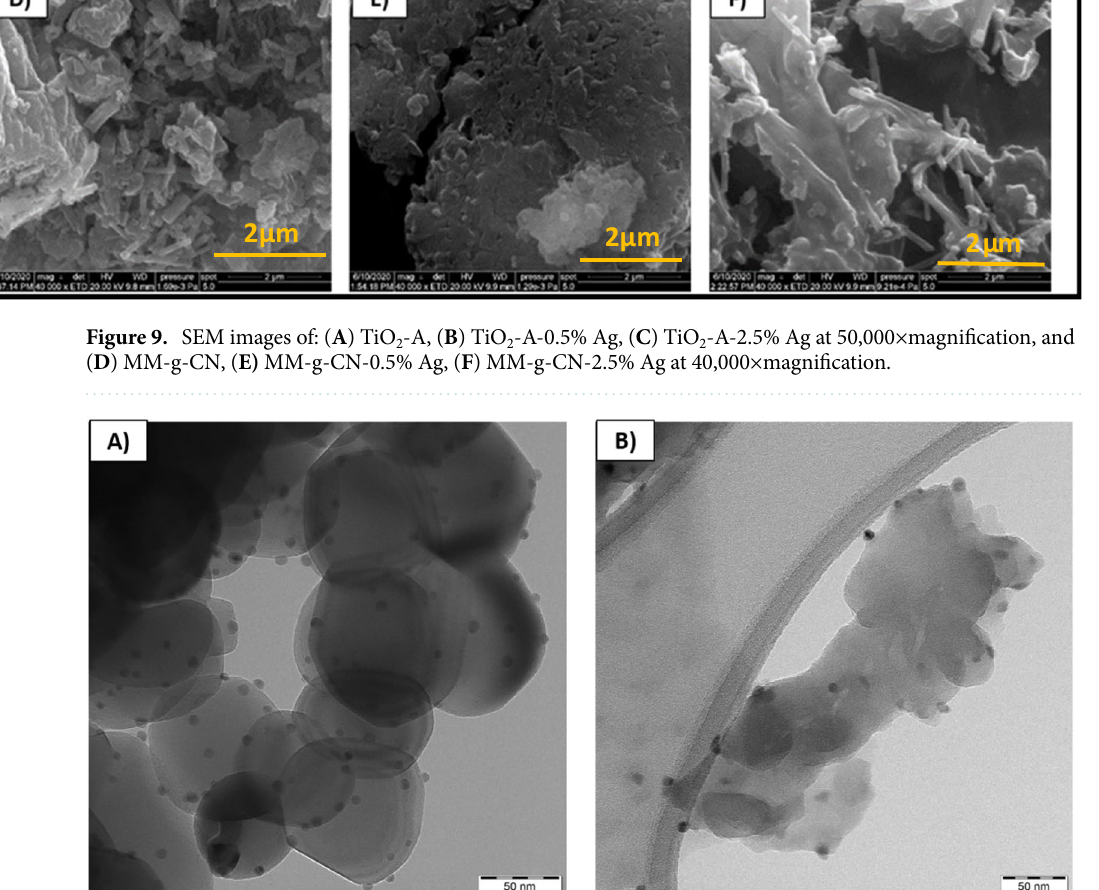
Figure 10. TEM pictures of: ( A ) TiO 2 -2.5% Ag and ( B ) MM-g-CN-2.5% Ag